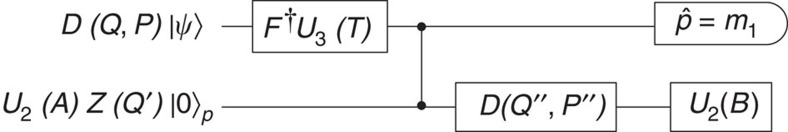
Server implementing a cubic gate.A quantum circuit demonstrating the implementation of U3(T) on a desired qumode held by the server (top wire). The client is able to correct for the U2(−3QT) gate in the decryption operation for U3(T) on-the-fly by sending an ancilla qumode (bottom wire). By choosing A and Q′ randomly and keeping these parameters hidden, the client is able to have the server implement the decryption without divulging information about the encryption parameter Q. The parameters Q″ and P″ are defined in Supplementary Note 1.